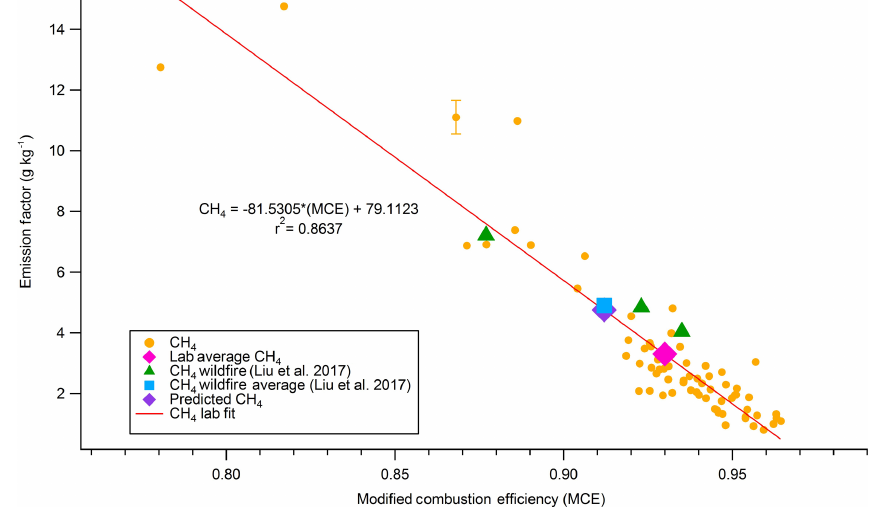
Figure 2. Methane emissions from 75 stack fires plotted against corresponding MCE and wildfire field methane emissions plotted against corresponding wildfire field MCE. Also included are the field-average methane emissions (blue) and the predicted methane emissions (purple) using the linear regression shown and a field-average MCE of 0.912. Table 2. Summary of the comparison of emission factors (gkg − 1 ) measured in the lab and field. Compound